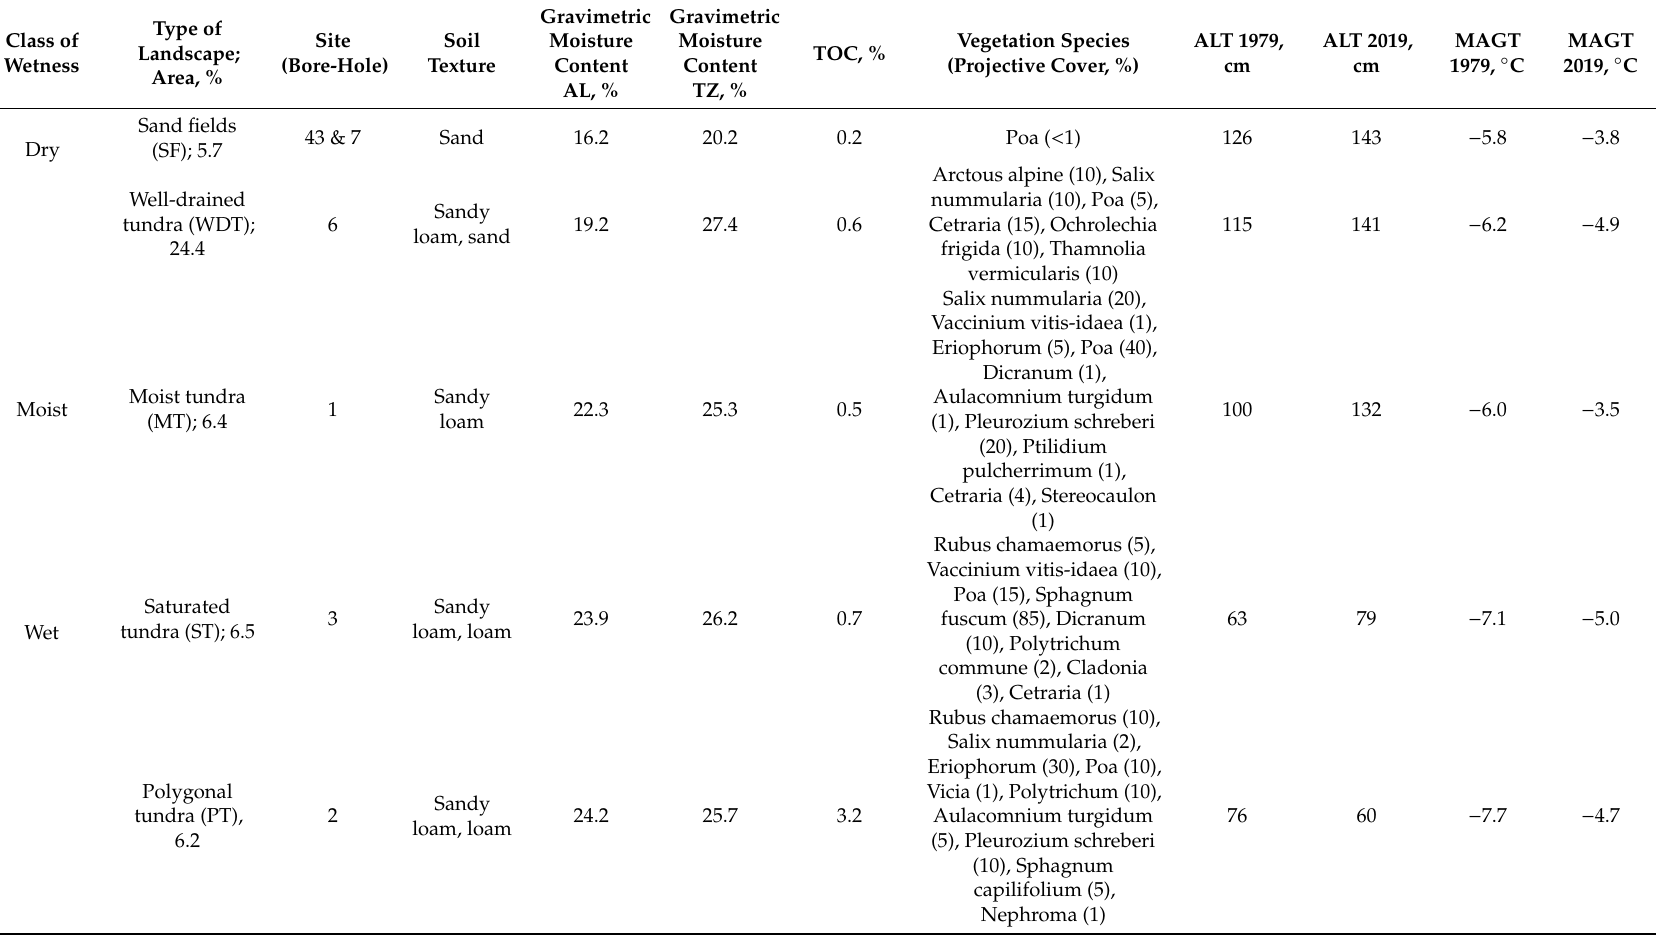
Table 1. Characteristics of the dominant landscapes and their vegetation cover. Abbreviations: AL—active layer, TZ—transition zone of the upper permafrost, TOC—total organic carbon, ALT—active layer thickness, MAGT—mean annual ground